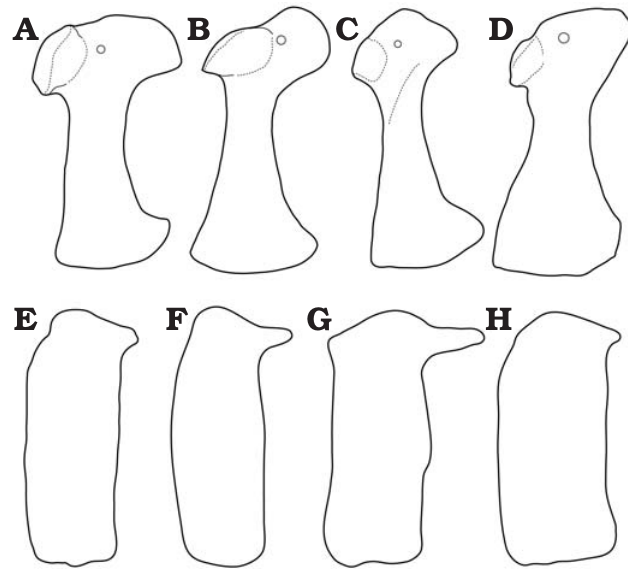
Fig. 3. Comparative morphology of coracoids (A–D) and dorsal scutes (E–H) in coelognathosuchians from the medial Cretaceous of North America. Right coracoids in lateral view and right dorsal scutes in ventral view. A , E . Dakotasuchus kingi Mehl, 1941, OMNH 34500, Mussentuchit Member of the Cedar Mountain Formation (Cenomanian), Utah,